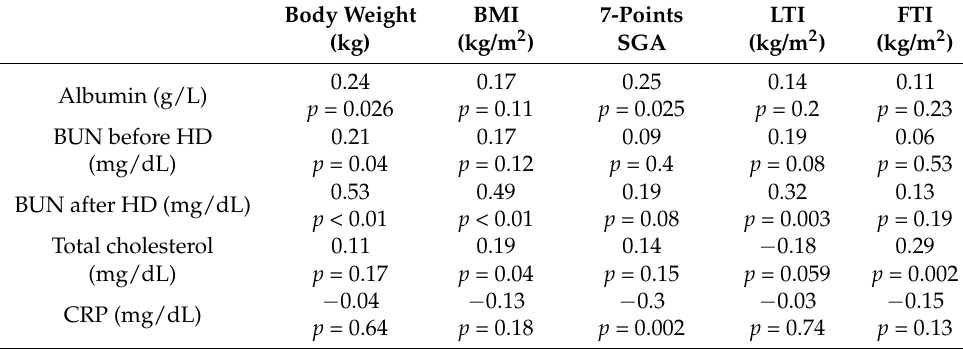
Table 7. Relationship between nutritional status, body composition, and biochemical